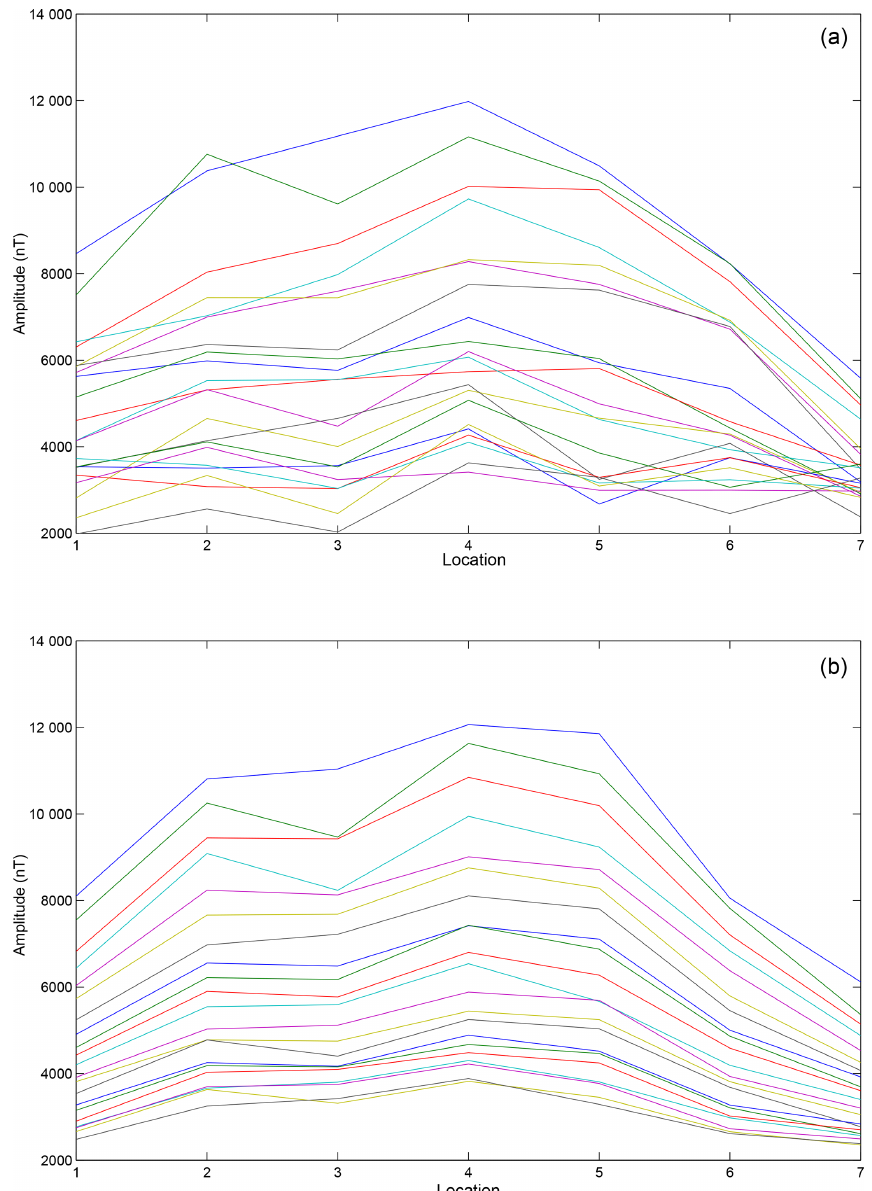
Figure 12. (a) The original 30th to 50th points from seven actual detecting locations. (b) The denoising 30th to 50th points from seven actual detecting